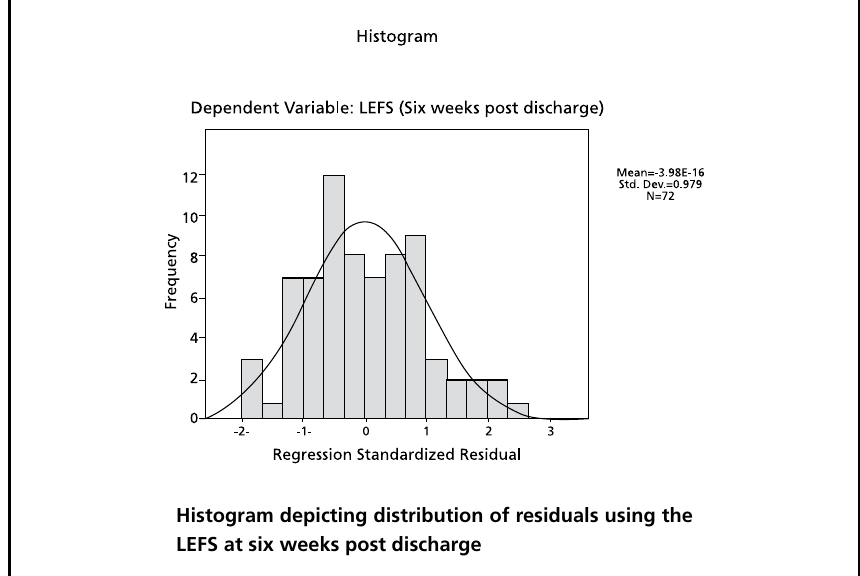
Figure 5: histogram depicting the distribution of variables using the lower extremity Functional scale at six weeks post discharge